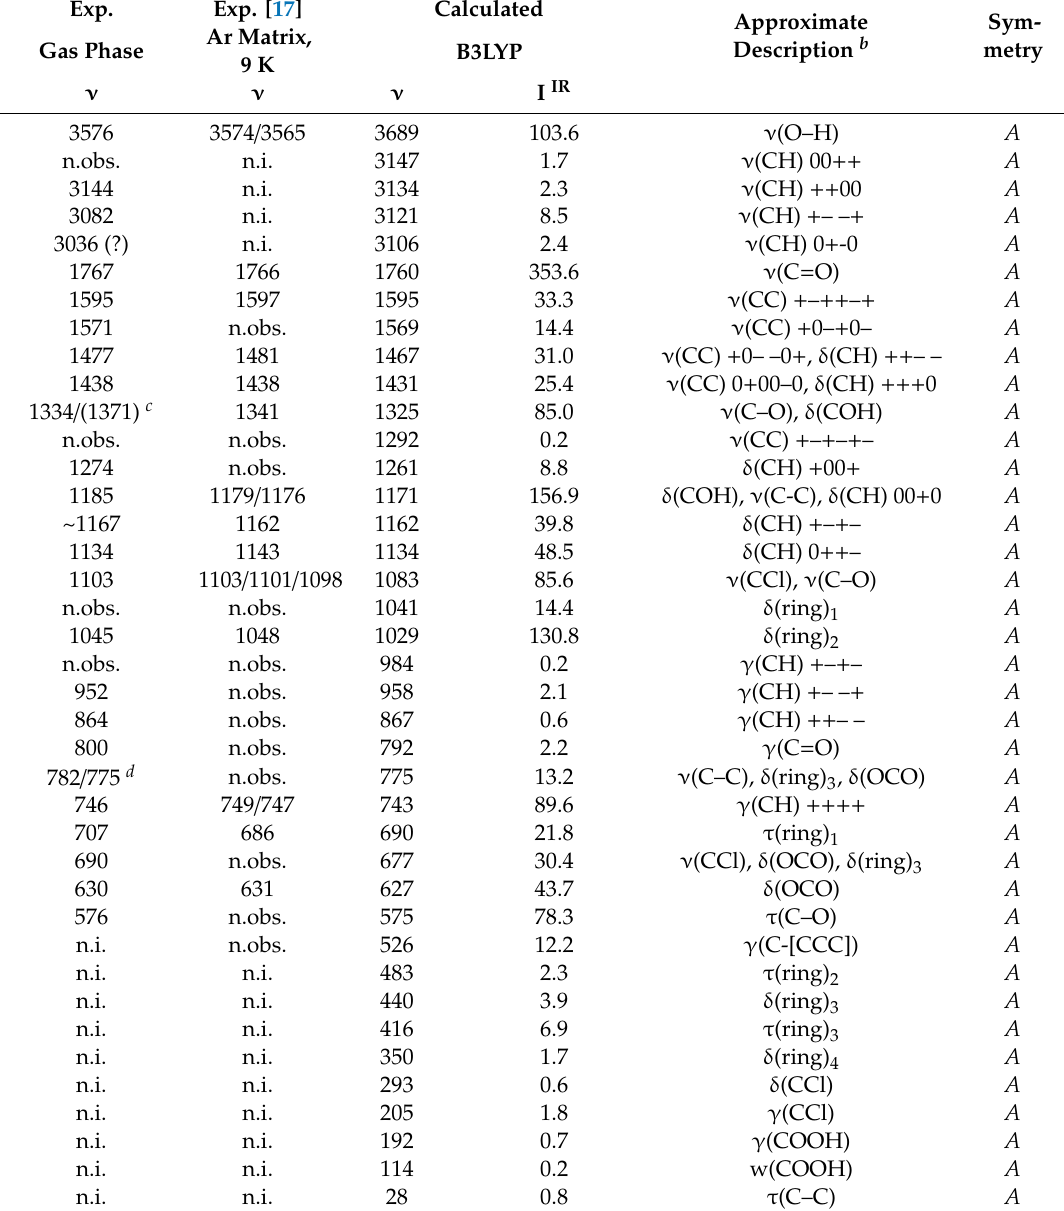
Table 4. Experimental (Exp.) and B3LYP / 6-311 ++ G(d,p) calculated (Calc.; cis -I conformer) infrared spectra of monomeric 2-chlorobenzoic acid, and band assignments a . Exp. Exp. [17]